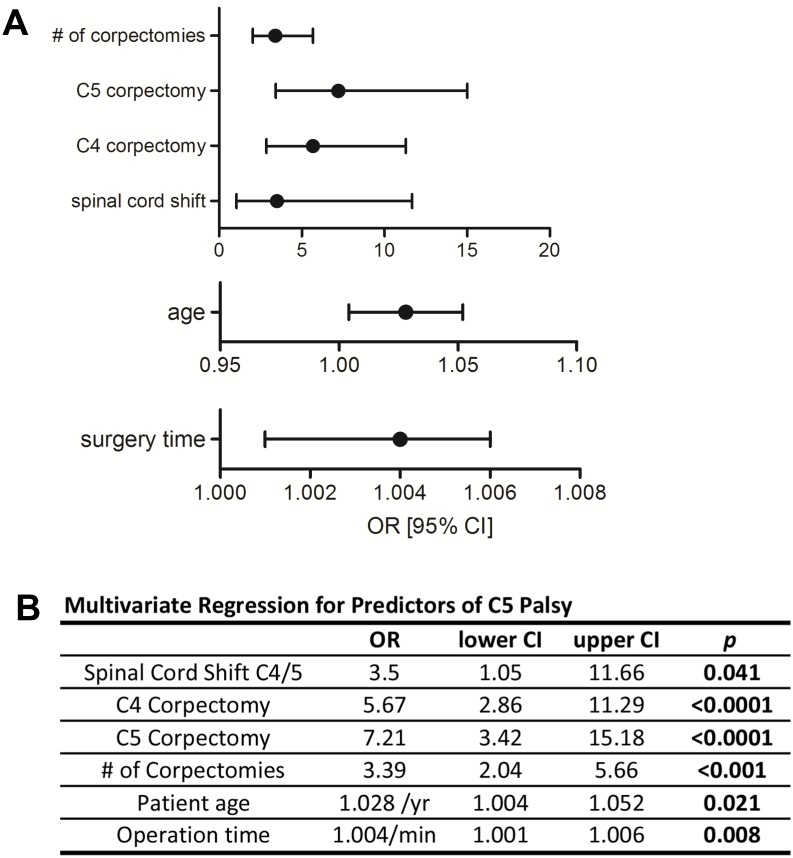
Multivariate regression analysis of predictive outcome parameters for C5 palsy rate as illustrated by forest plots (A). Dots indicate the odds-ratio (OR) and whiskers for 95% confidence interval (CI). Integrated table (B) shows the corresponding statistical values including the p-value after regression analysis.